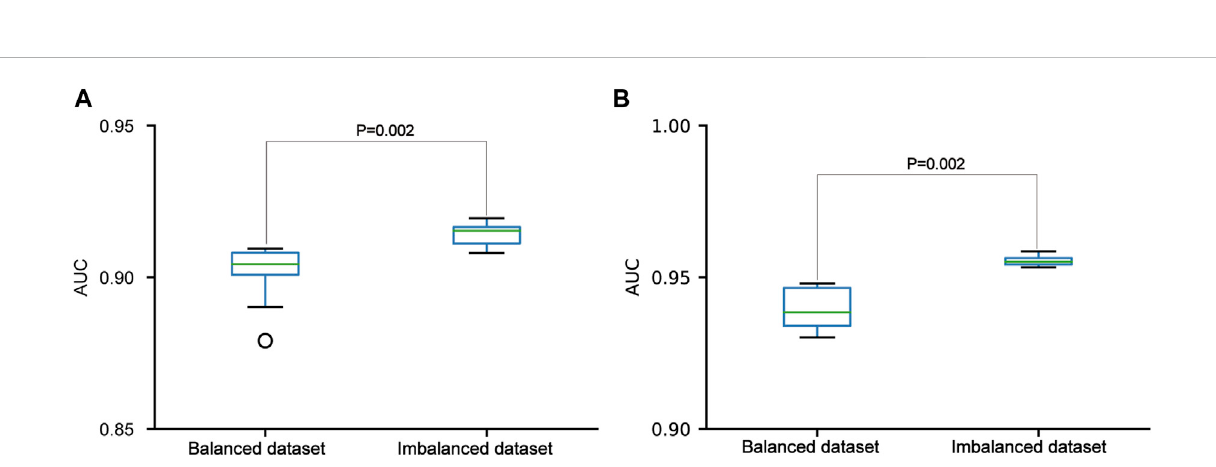
Frontiers in Cell and Developmental